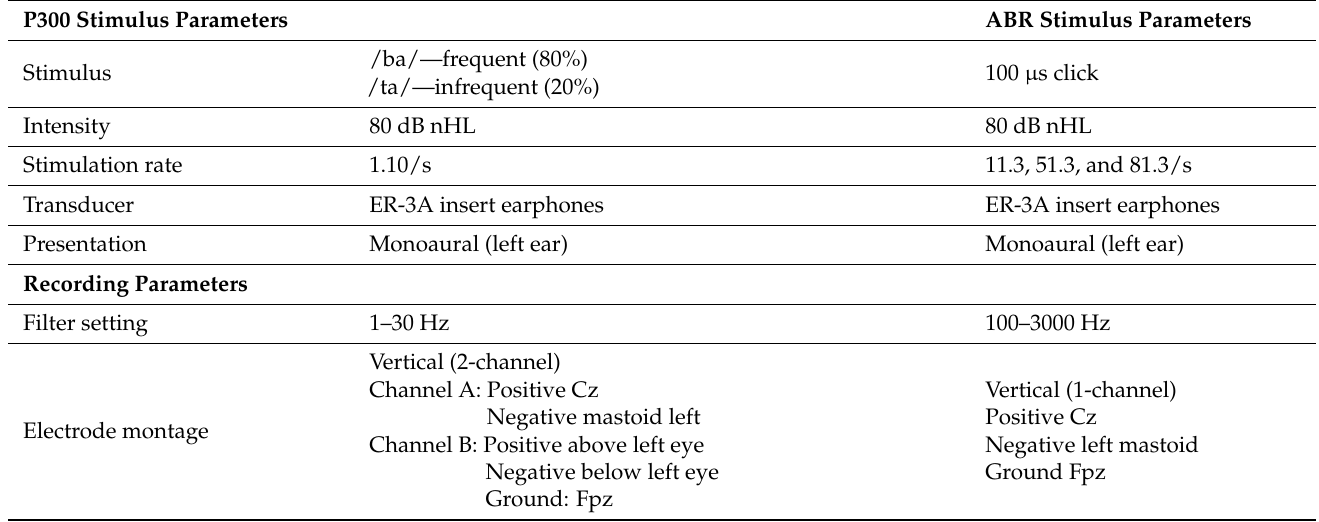
Table 1. Stimulus and acquisition parameters set to record ABR and